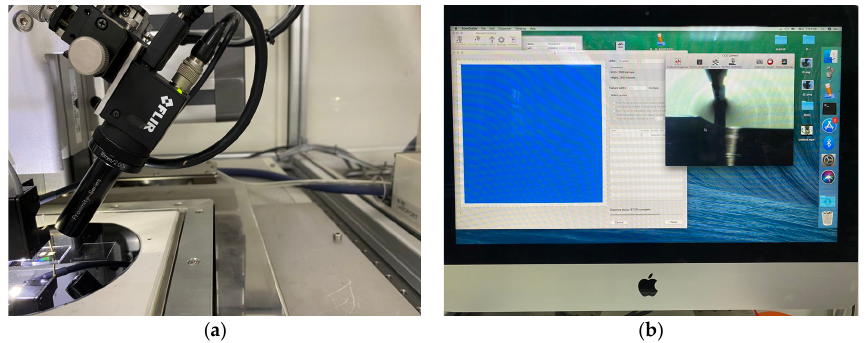
Figure 3. High-precision micro-nano-material deposition system for printing silver electrodes. ( a ) Enlarged view of the silver electrode printed on the PDMS flexible substrate; ( b ) host real-time display when the electrodes were printed on both sides of the silicon nanomembrane.